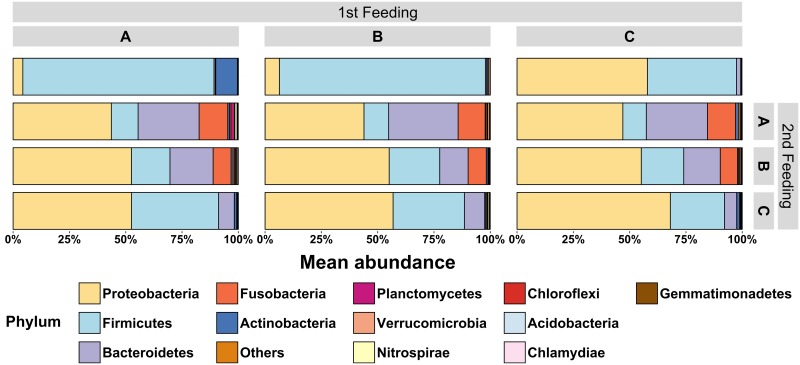
Mean relative abundance of phyla present in the intestinal tract samples of trout fry in relation to the dietary treatment.The top 13 phyla present in at least 10% of all samples and counting for at least 1% of all observed OTUs were included in the analysis; the remaining phyla were aggregated into “Others”.